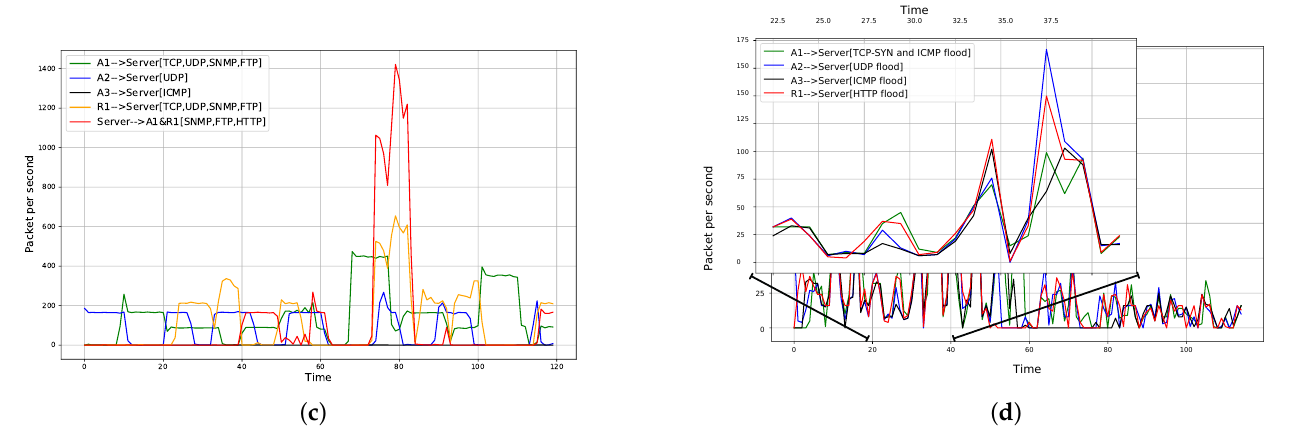
Figure 8. Traffic generated during the four phases: ( a ) low normal traffic; ( b ) low attack traffic; ( c ) high normal traffic; ( d ) high attack traffic.